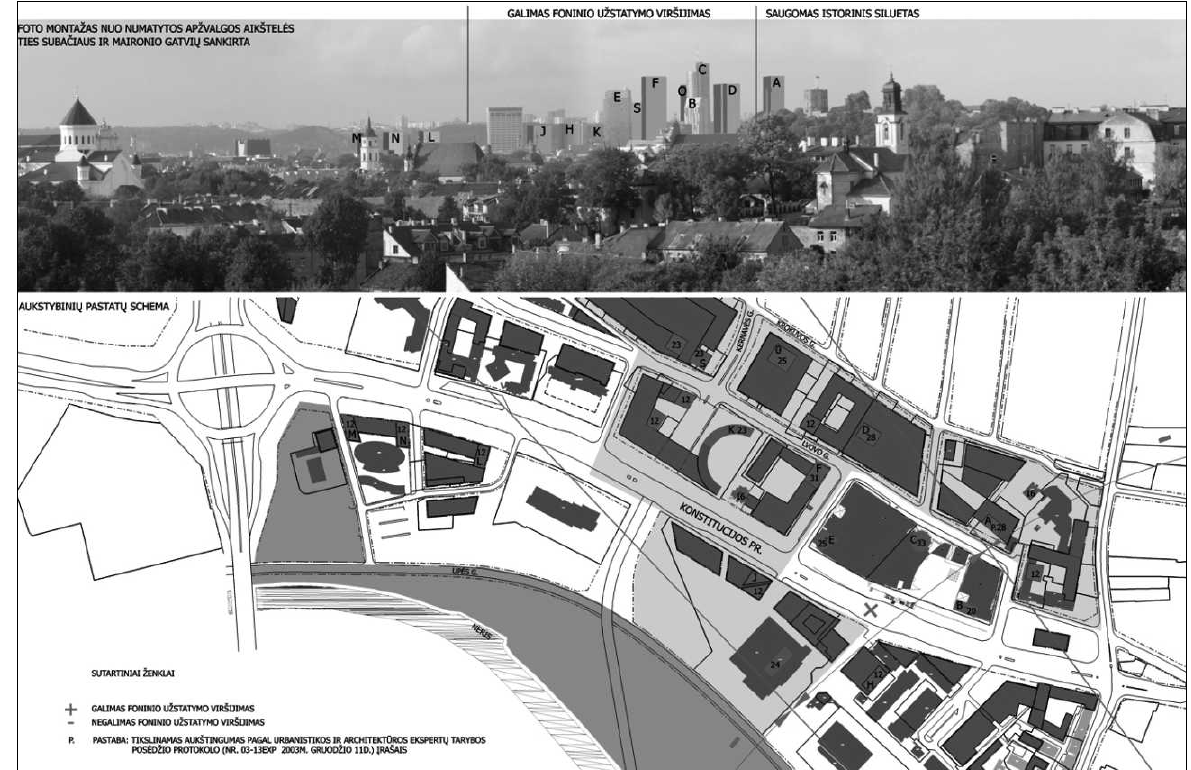
Fig 16. Urban conception of Šnipiškės area („Vilniaus planas“,